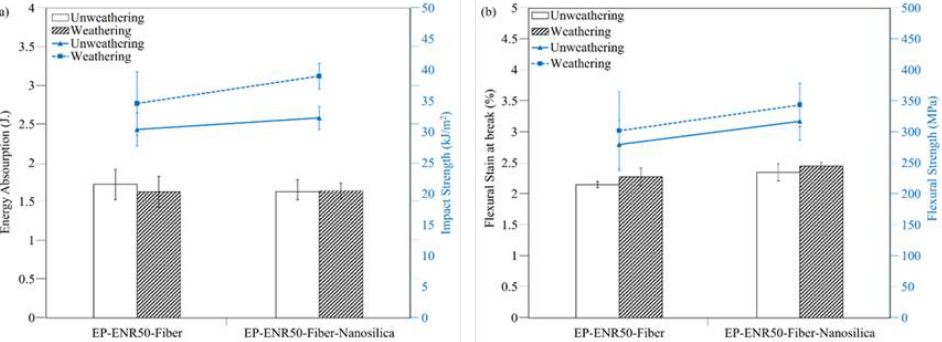
Figure 8. The mechanical properties of wind blade nanocomposites after accelerated aging: ( a ) impact strength and ( b ) flexural strength.